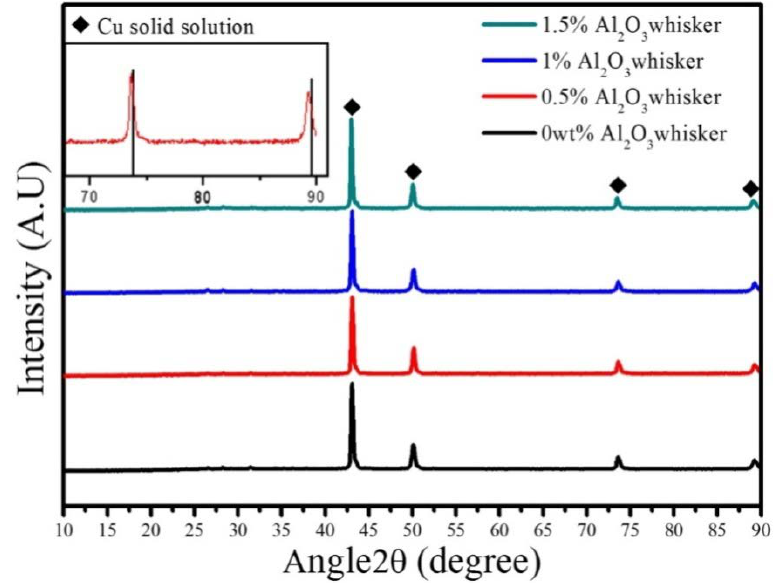
Figure 4. XRD patterns of the sintered composites with different contents of alumina whiskers. Comparison with copper standard card (70-3038) shown in the upper left panel.